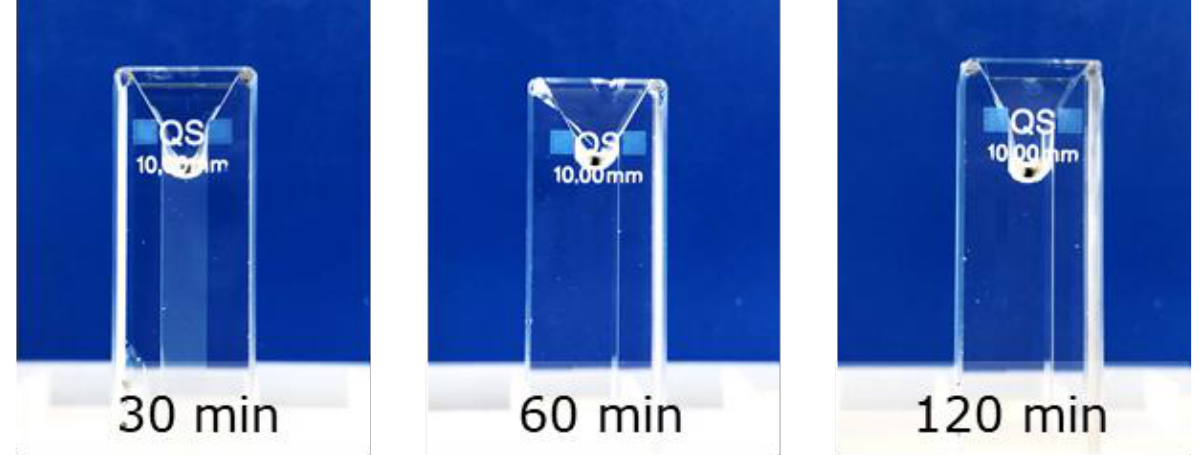
Figure 2. Pictures of chitin powder dispersed in 85% phosphoric acid at different times. After 30 min of solubilization, the sample still looked turbid, but after 60 min the sample seems com- pletely dissolved and no particles could be observed with the naked eye, although there was a background signal.